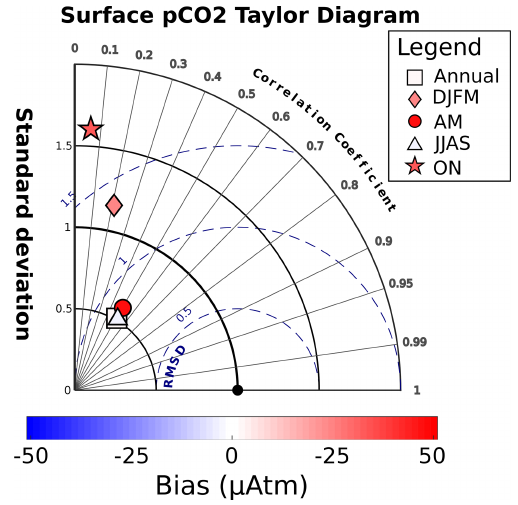
Figure 4. Taylor diagram of modeled vs. observed surface p CO 2 , both annually and seasonally. Data are from merged SOCAT and LDEO databases, corrected to the year 2005. Distance from ori- gin (concentric solid lines) is normalized model standard deviation. Angle from vertical axis is Pearson correlation coefficient. Distance from observation point (black dot) is root-mean square deviation (dashed blue lines). Color of each point denotes model bias; i.e., positive values are